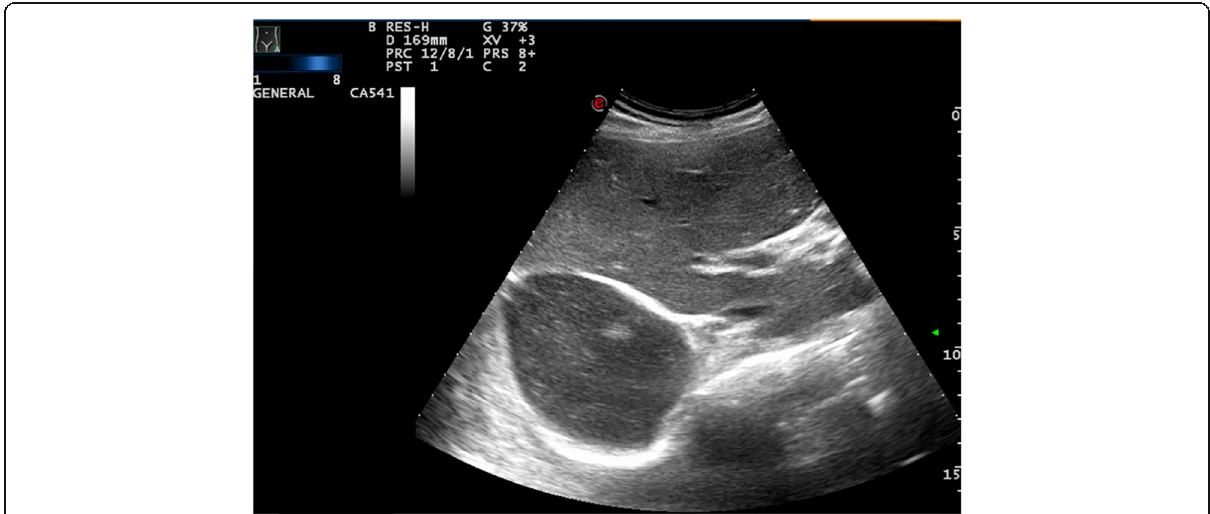
Fig. 2 Ultrasonographic image of ALA in a male patient at Teaching Hospital Jaffna, demonstrating a solitary large right lobe liver